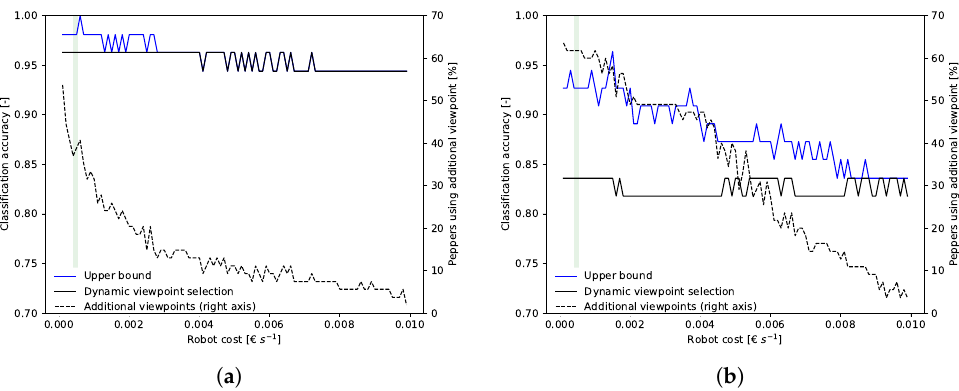
Figure 9. Influence of robot costs on the average number of viewpoints and the classification accuracy for the red ( a ) and yellow ( b ) peppers. The robot costs in the green area are regarded to be realistic, as mentioned in Section 2.2.3.2.